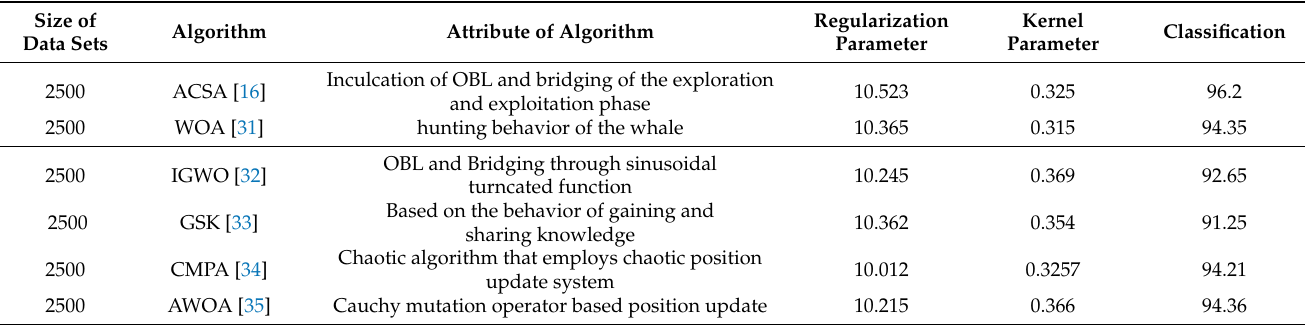
Table 3. Comparative analysis of different optimization algorithms for hyper-parameter